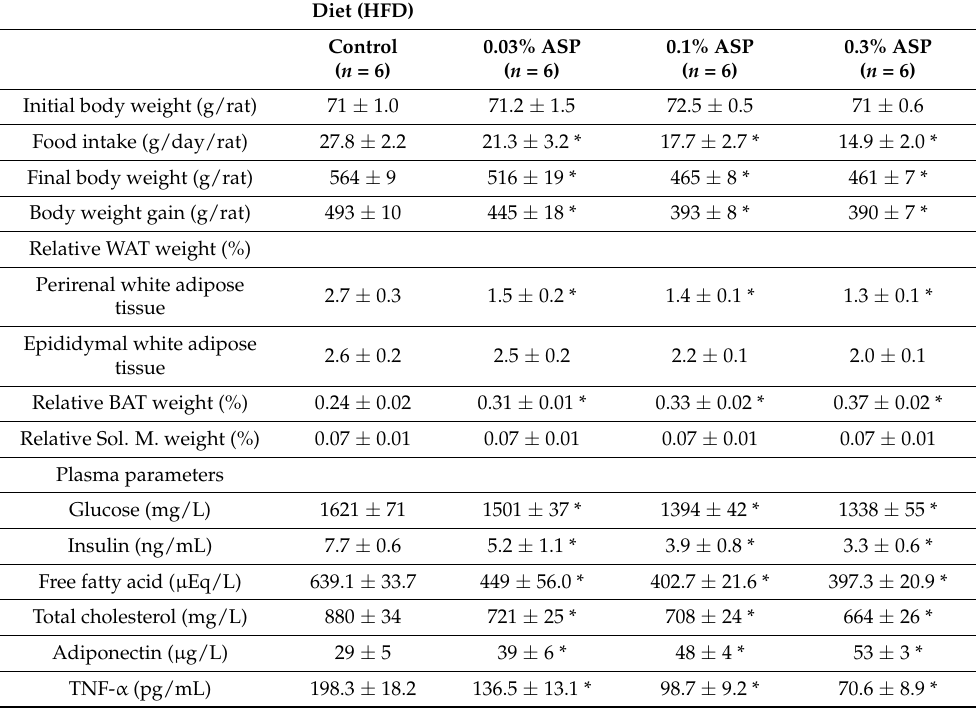
Table 11. Effects of ASP on physical and plasma parameters in HFD-fed rats after three